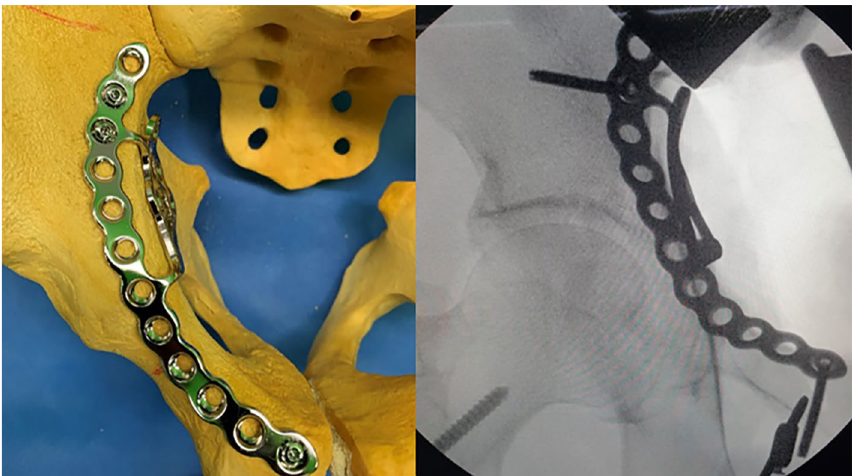
Figure 6. Insertion of the screw in the third hole from the back of a suprapectineal portion of the plate while the pushers were maintained on the